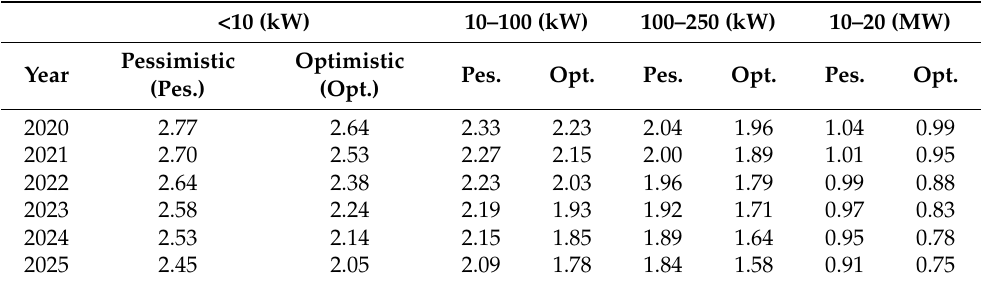
Table 6. Forecasted values of c u,P till the year 2025 in both an optimistic scenario and a pessimistic